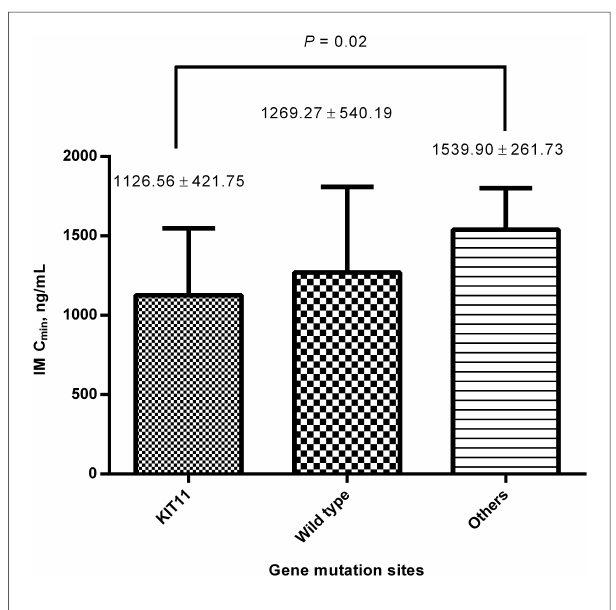
FIGURE 5 Comparison of IM C min between different gene mutation sites within the medication for 12< – ≤ 36 months. The IM C min was much higher in patients with mutation sites other than KIT exon 11 mutations. IM, imatinib; C min , plasma trough